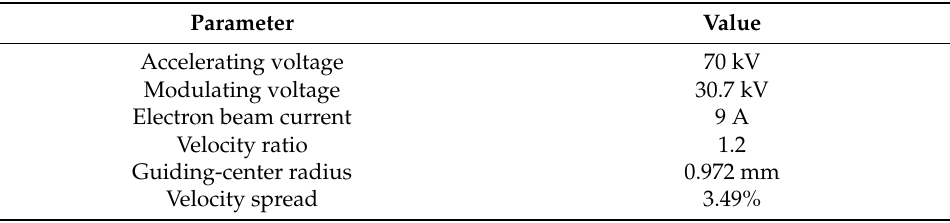
Figure 7. Electron trajectories of the optimized MIG. Table 2. Beam properties of the optimized MIG.